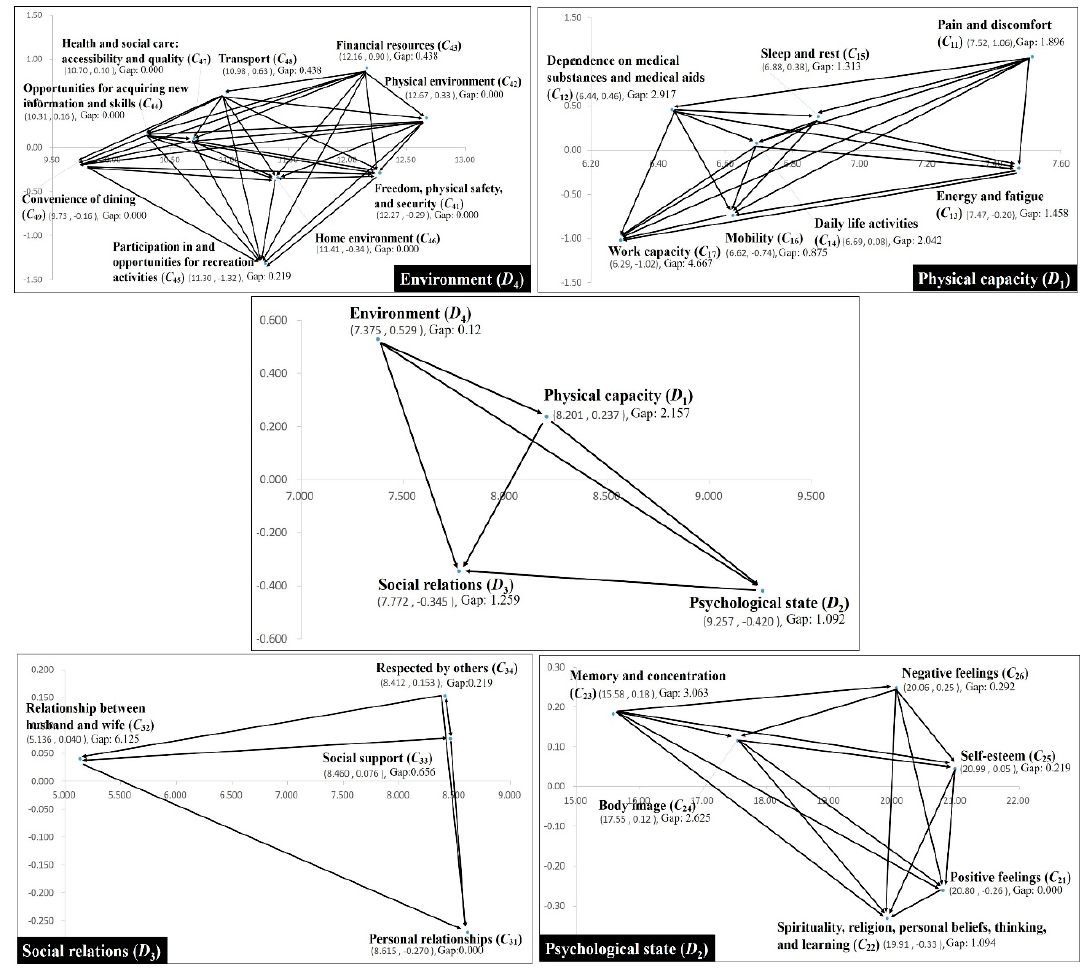
Figure 3. Procedure of the modified DANP-mV model.